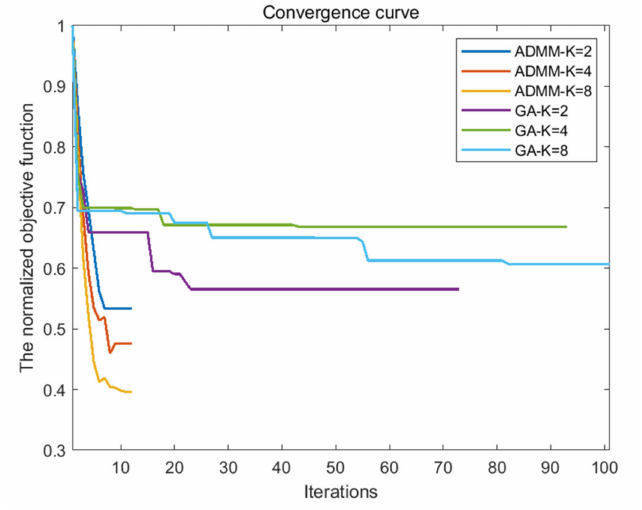
Figure 3. Comparison of convergence curve between SSD–ADMM and